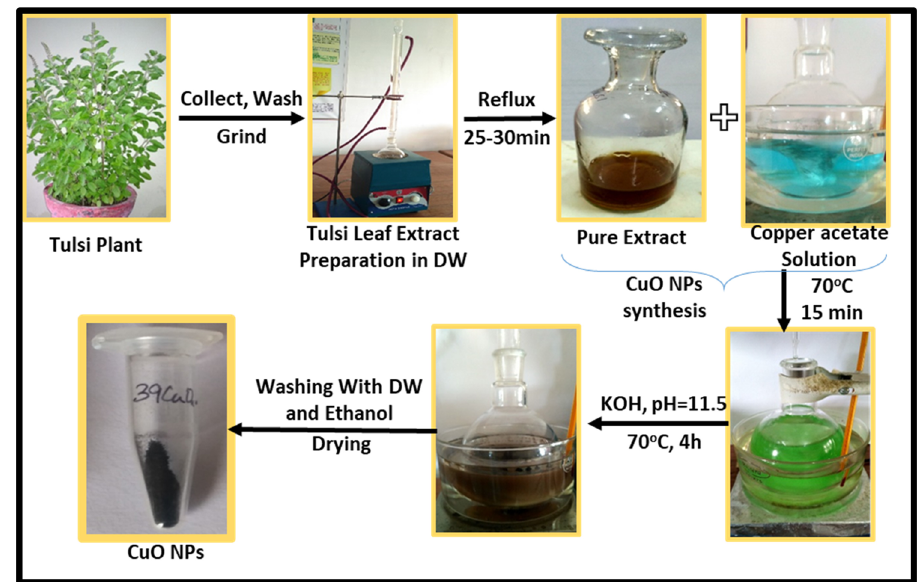
Figure 25: Synthesis of CuO NPs. Copied with permission from ref. [ 299 ] ; Elsevier, 2021.